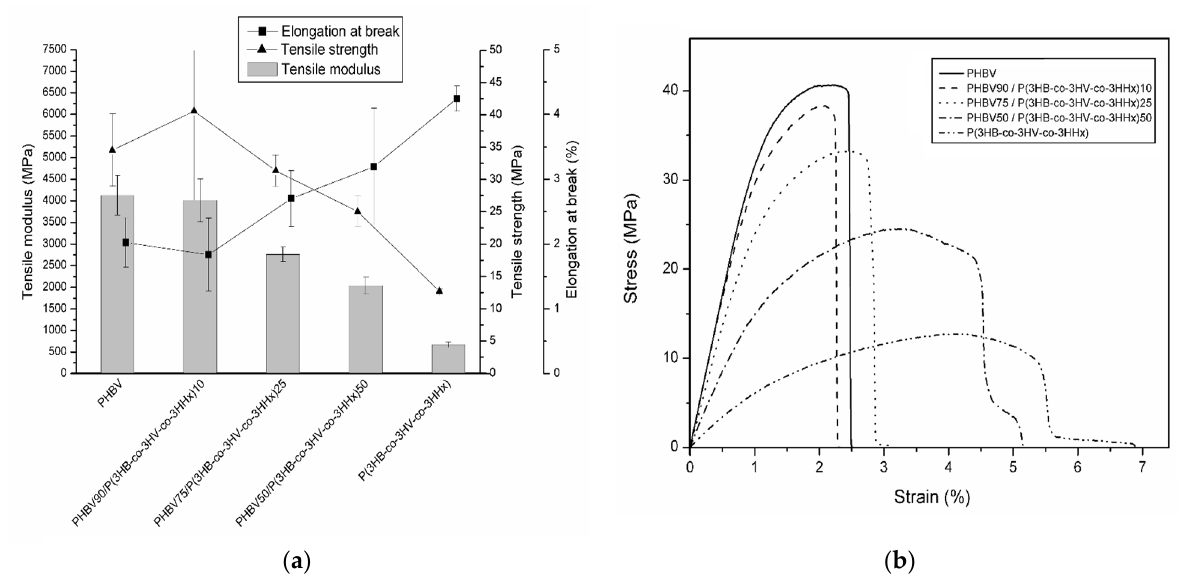
Figure 6. ( a ) Mechanical properties of the thermo-compressed films of poly(3-hydroxybutyrate- co -3-hydroxyvalerate) (PHBV), poly(3-hydroxybutyrate- co -3-hydroxyvalerate- co -3-hydroxyhexanoate) [P(3HB- co -3HV- co -3HHx)], and their blends in terms of: Tensile modulus, tensile strength, and elongation at break. ( b ) Their corresponding tensile stress–strain curves.